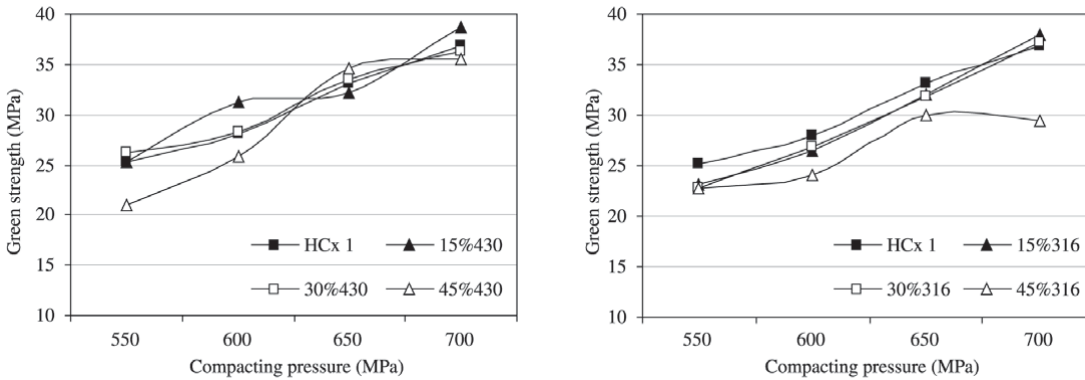
Figure 2. Green strength of diluted materials vs. compacting pressure.